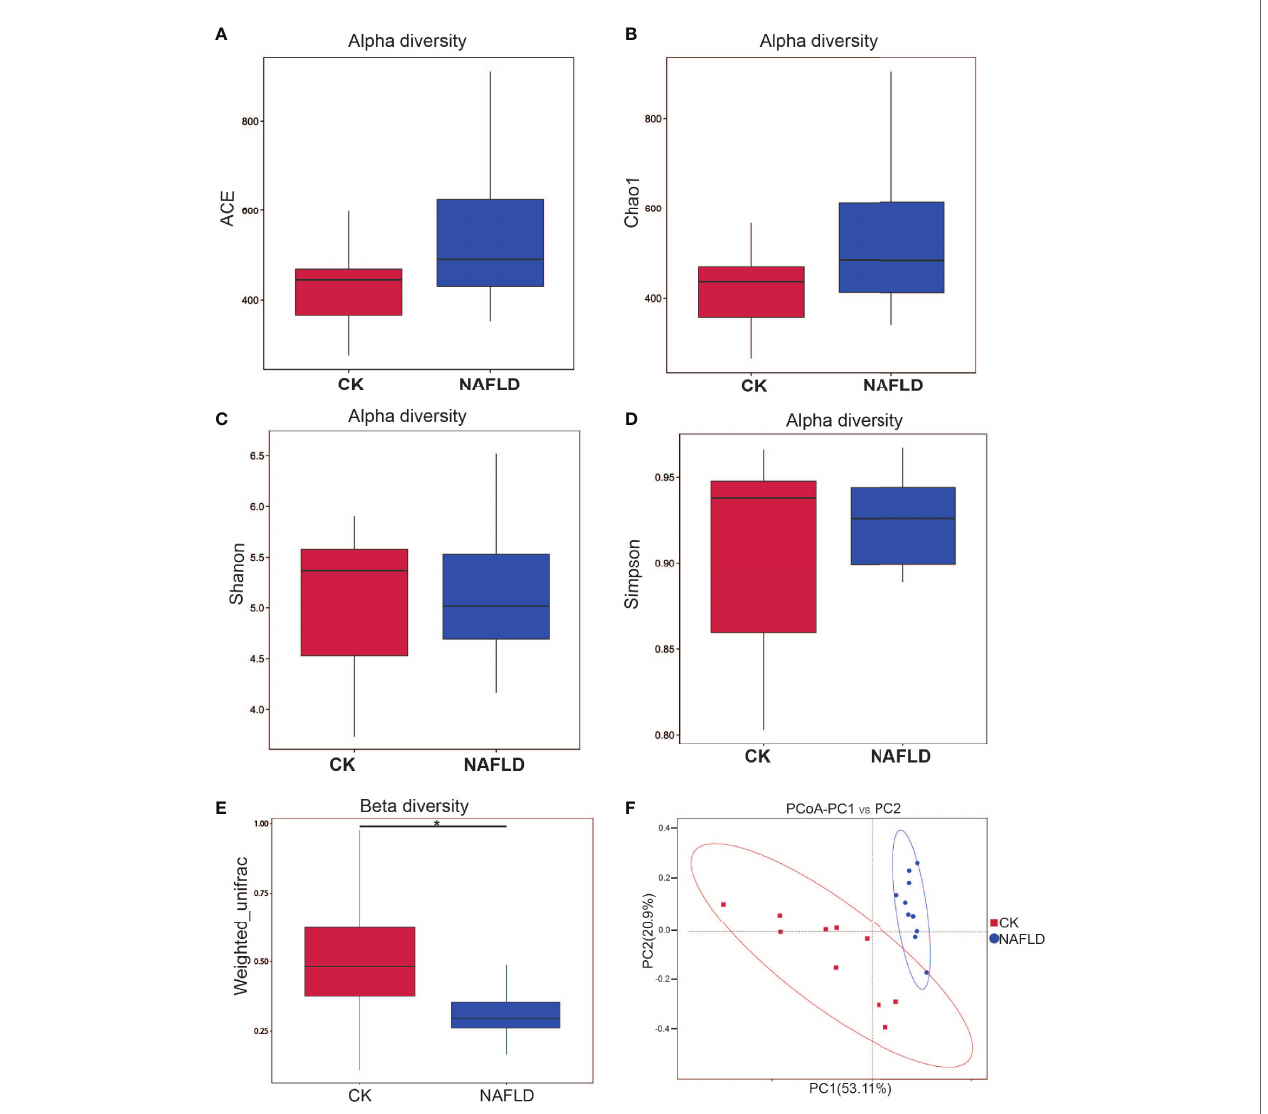
FIGURE 3 | Alpha and beta diversity analysis of the bacterial community in the cecal contents of Control and NAFLD mice. (A-D) ACE, Chao1, Shannon, Simpson indexes had no signi fi cant difference between Control and NAFLD mice. (E, F) Beta diversity assessed by using PCoA of weighted UniFrac distance metrices had signi fi cant difference between Control and NAFLD mice. “ * ” indicated p-value < 0.05, (Wilcox Rank-Sum